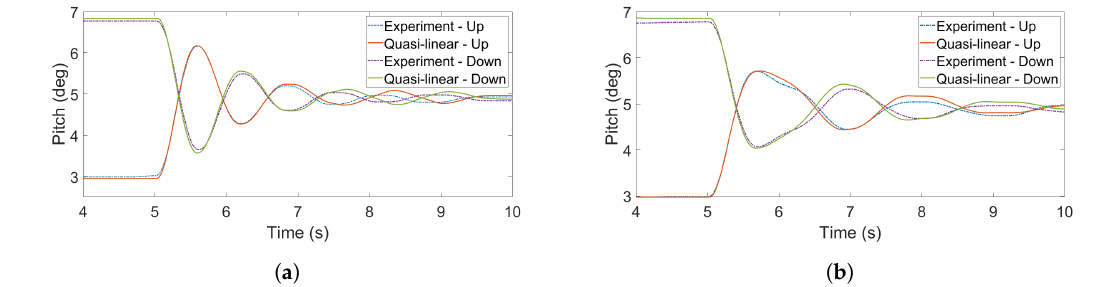
Figure 18. Experimental (“Exp”) and simulated (“Sim”) decay tests comparison at two different starting positions (“Up” and “Down”). The quasi-linear numerical model computes moments linearly except from an approximated quadratic drag moment. The model inputs a drag coefficient Cd = 2 and a constant moment due to friction in the bearings calculated with K fb = 0.4 Nm. ( a ) Experimental and numerical results of decay tests for the case of WEC only. ( b ) Experimental and numerical results of decay tests for the case of WEC with bottom